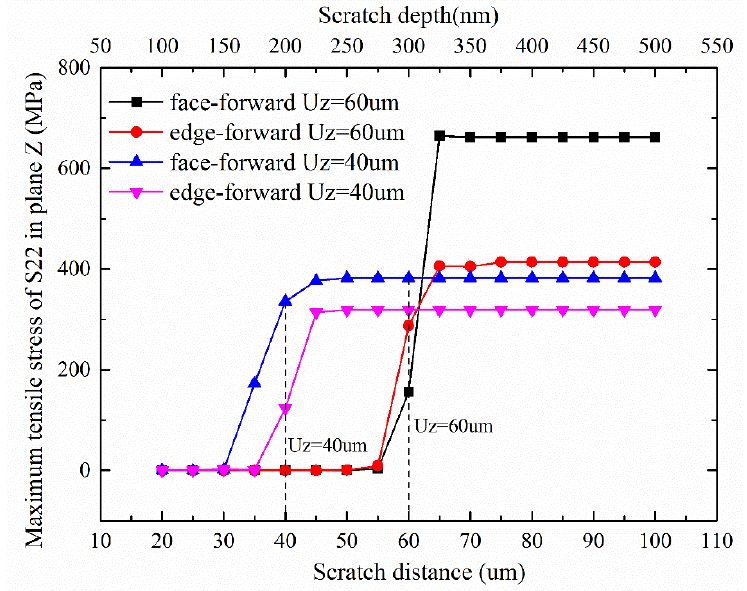
Figure 12. The maximum value of the cross section S 22 stress with the scratch depth under different scratch directions.